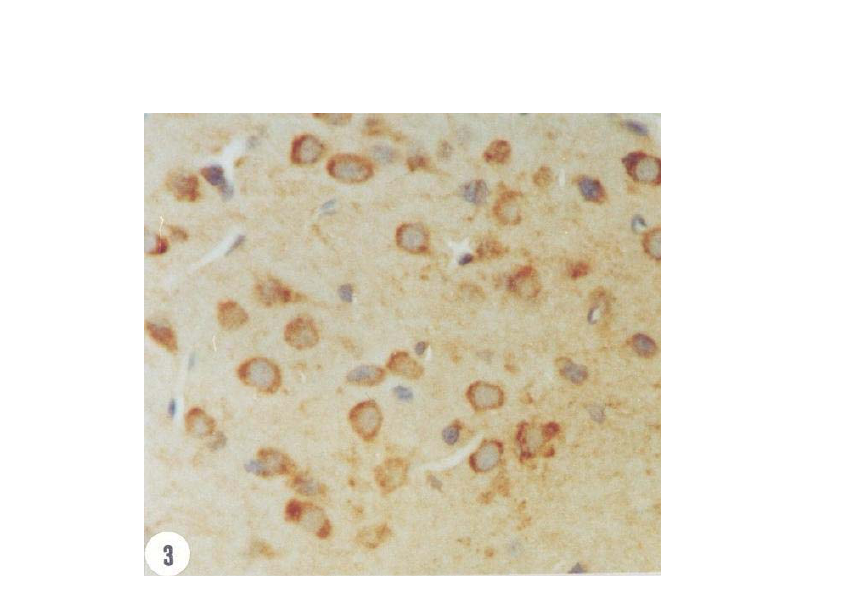
Figure 3. Control cerebral cortex of a rat showing positive NSE immunoreactivity in the neuron cytoplasm. (X400)